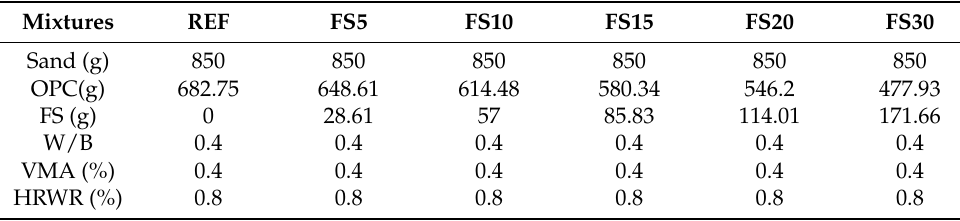
Table 2. Mix design of tested mortars.